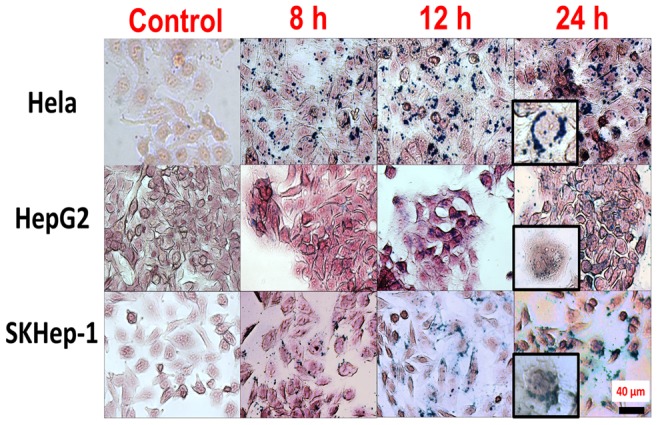
Prussian blue staining results of cancer cells internalizing magnetic nanoparticles (MNP) in a time dependent manner.Control corresponds to the cells (HepG2, SKHep-1, HeLa) that were not treated with MNPs and maintained for 24 h in parallel to the treated groups. Insets: the enlarged images of cells. Blue: MNPs; Red: nucleus. The scale bar in each image represents 40 µm.